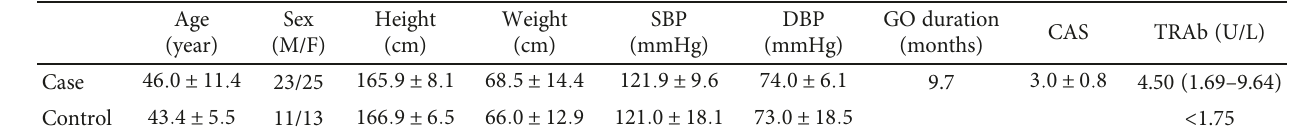
Table 1: Characteristics of cases and controls for